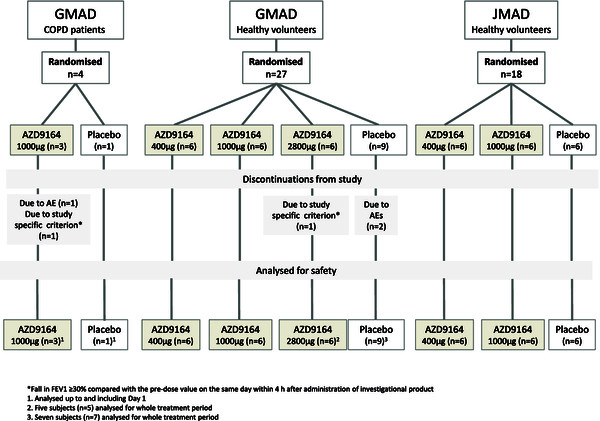
CONSORT patient flow diagram.